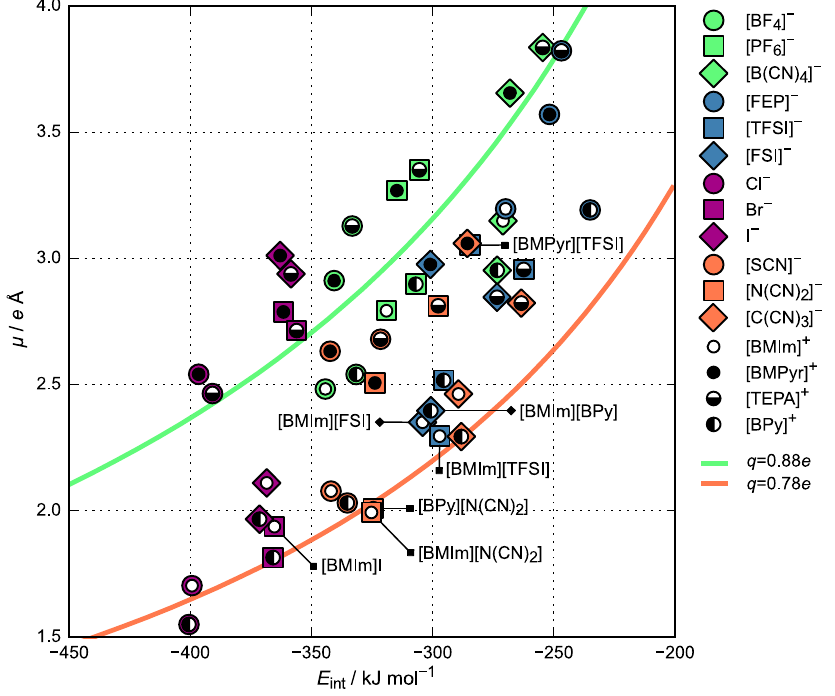
Figure 3. Dipole moment dependence on the interaction energies of ionic pairs. Each of the inner circles indicates a cation and the surrounding marker indicates an anion of an ionic pair.